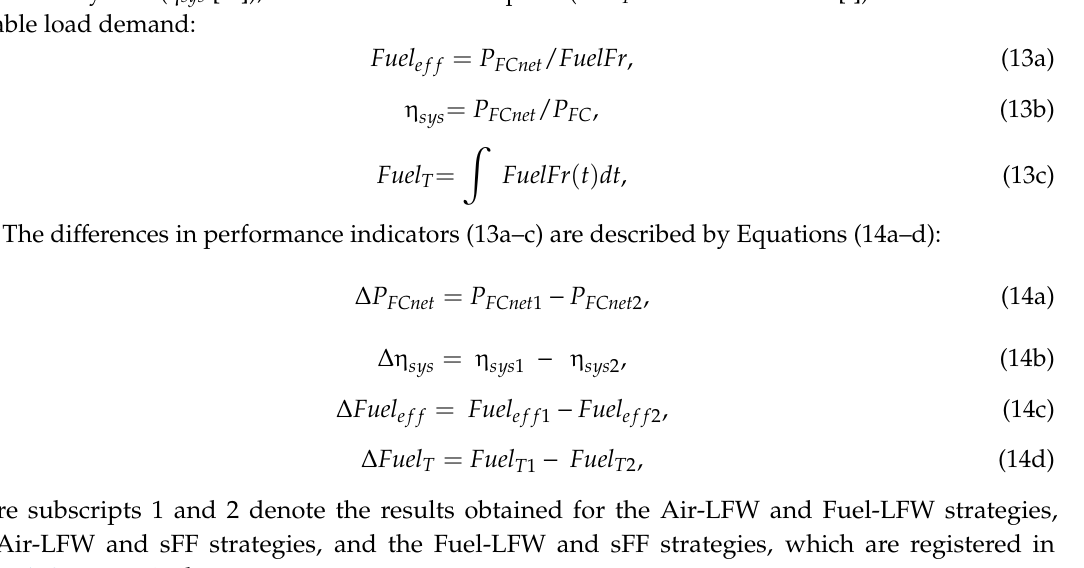
Table 1. The gaps in performance indicators for the Air-LFW and Fuel-LFW strategies ( P RES = 0). P load [kW]